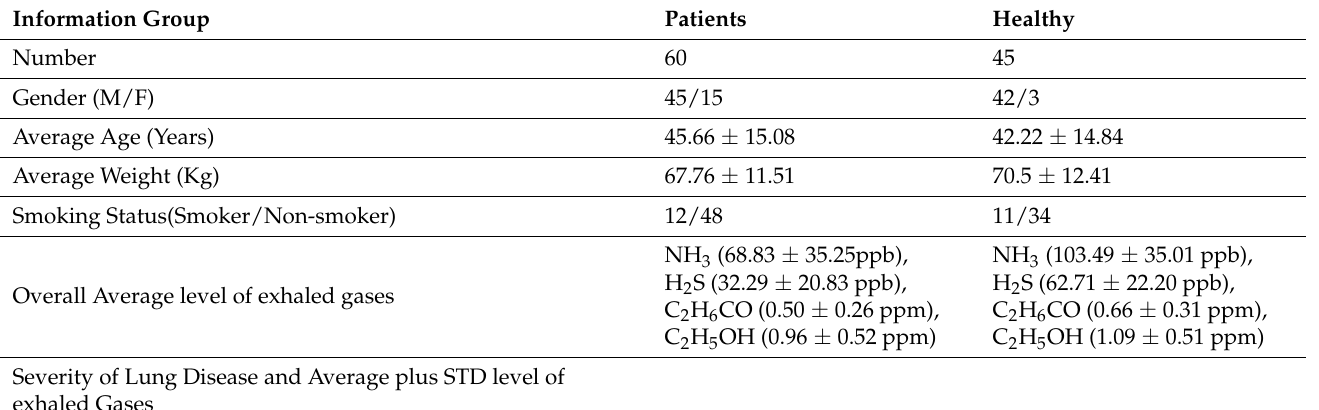
Table 2. Comparison of demographic and clinical characteristics. Significant difference of clinical characteristics was found for obstructive lung patients and healthy